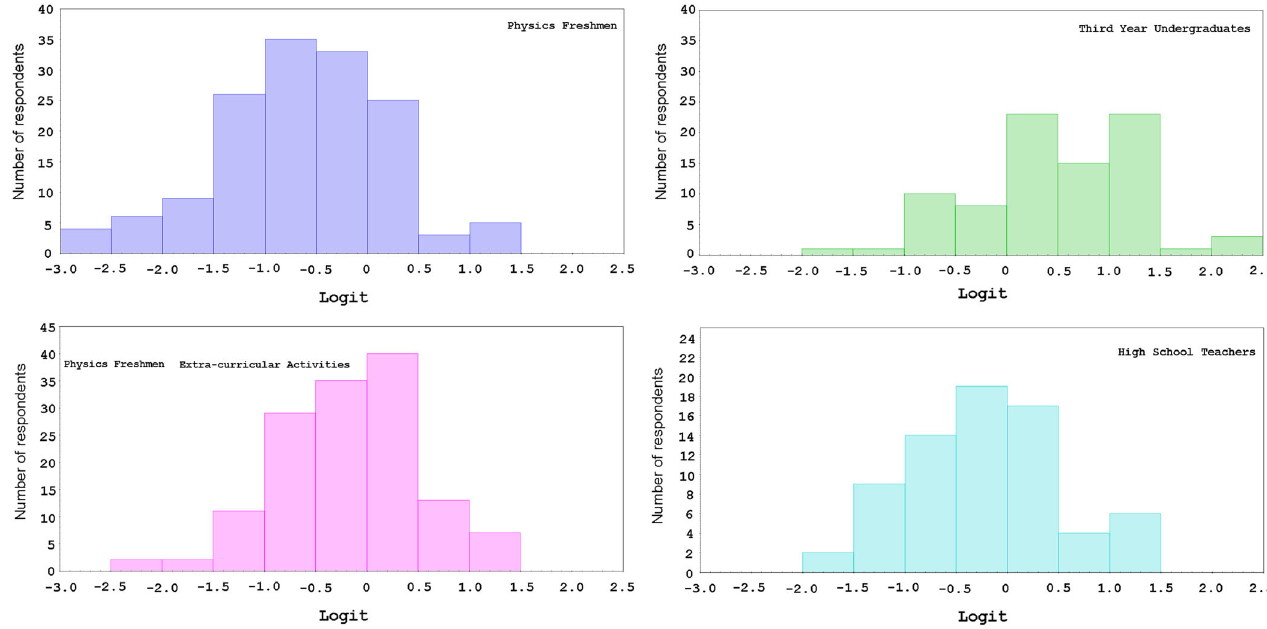
FIG. 3. Ability distributions of the four groups involved in the study. One extreme person (ability ¼ − 4 . 63 logit) is not